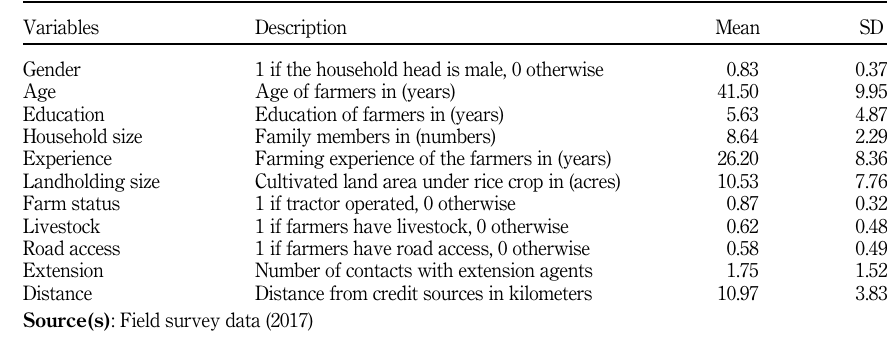
and measurement of the study